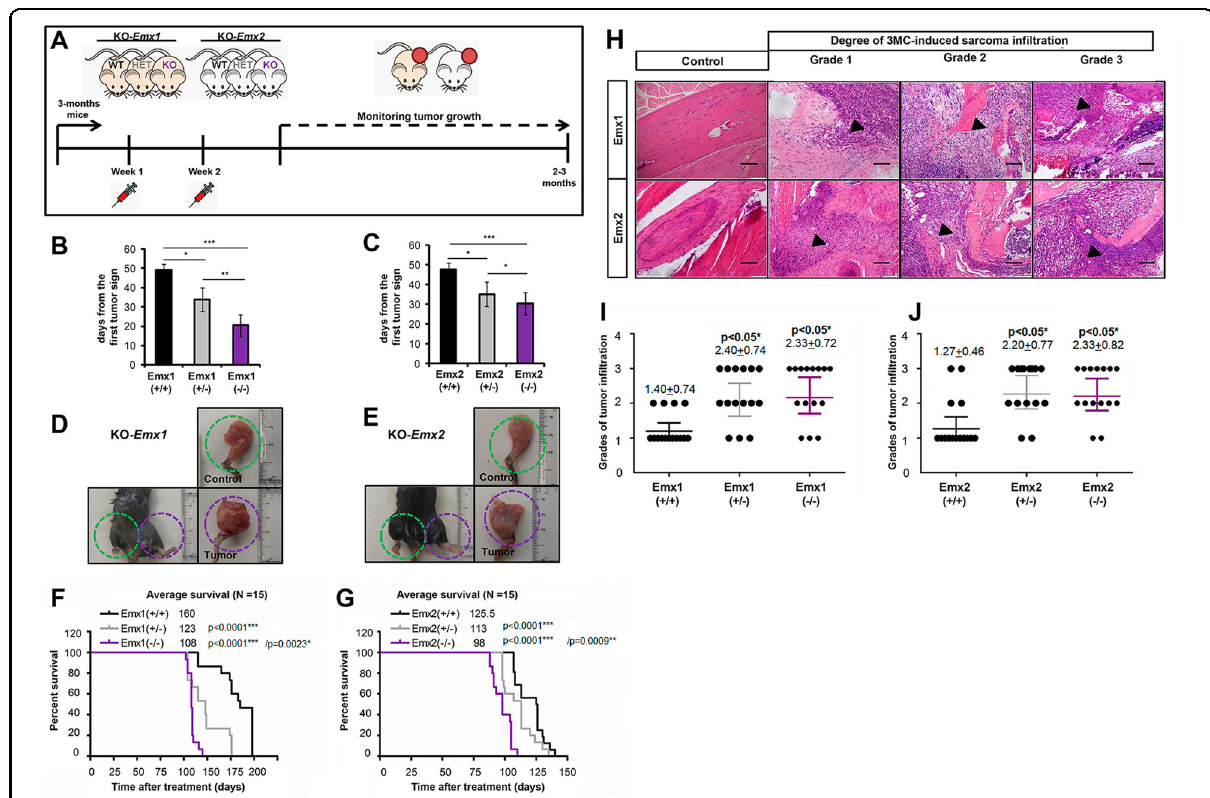
Fig. 5 Model of sarcomagenesis in vivo induced by 3MC in the different cohorts of Emx1 or Emx2 KO mice. A Scheme of the experimental procedure and monitoring of intramuscular carcinogenic induction mediated by 3MC in murine models of Emx1 and Emx2. Each cohort comprised 15 mice. B , C Graph of the days since the fi rst tumor sign in each cohort of Emx1 ( B ) and Emx2 ( C ). F , G Survival curve with respect to time post treatment with 3MC in Emx1 ( F ) and Emx2 ( G ). D , E Representative photographs of the control and tumor limbs of each Emx1 ( D ) and Emx2 ( E ) cohort. The p -value of the survival graphs was obtained using the LogRank test. The rest of the analysis was performed with Student ’ s t -test (* p < 0.05; ** p < 0.01; *** p < 0.001). H – J Effect of Emx1 or Emx2 depletion on the tumor invasiveness of the bone marrow of the femur in the 3MC-induced sarcomas. In H , representative micrographs of the three grades into which the evolution of the tumor in fi ltration of sarcoma induced by 3MC in the bone marrow has been divided with respect to the control tissue. The points of initiation or progression of the in fi ltration are highlighted with the arrowhead. The bar indicates 200 µm. I , J Graphs of the degree of tumor in fi ltration measured in the Emx1 ( I ) and Emx2 ( J ) KO line cohorts. Each cohort had 15 mice. Statistical analysis was performed with Student ’ s t -test (* p < 0.05; ** p < 0.01; *** p <